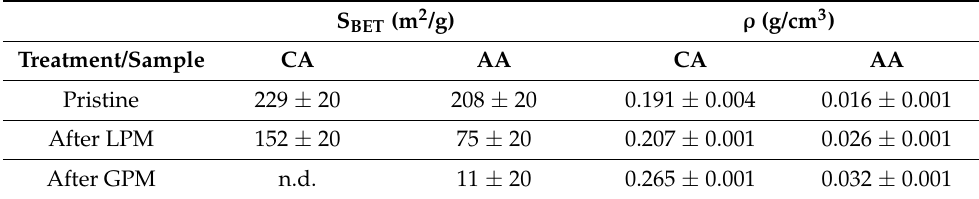
Table 1. Physical characterization of pristine coffee and apple aerogels (CA and AA), and after hydrophobic surface modification (HCA and HAA). n.d. means not detectable. S BET (m 2 /g)